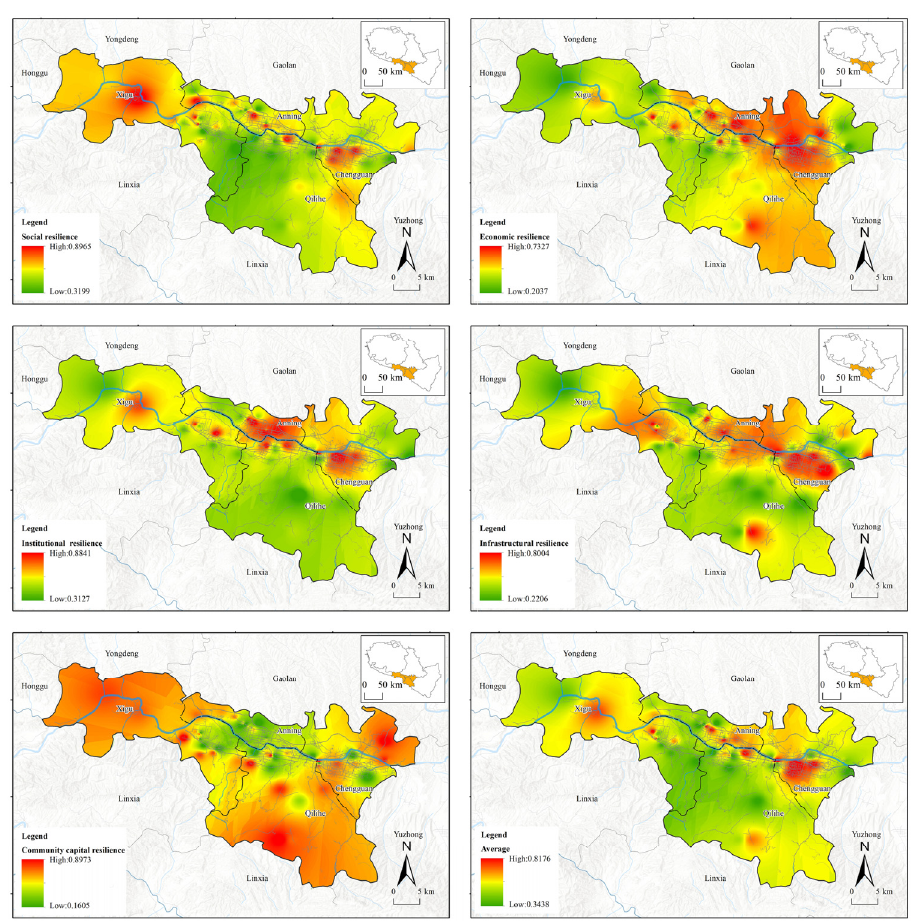
Figure 3. Distribution map of perceived resilience in different dimensions in Lanzhou. (3) The areas with high values of community capital resilience show the characteristics of fleeing from the central urban